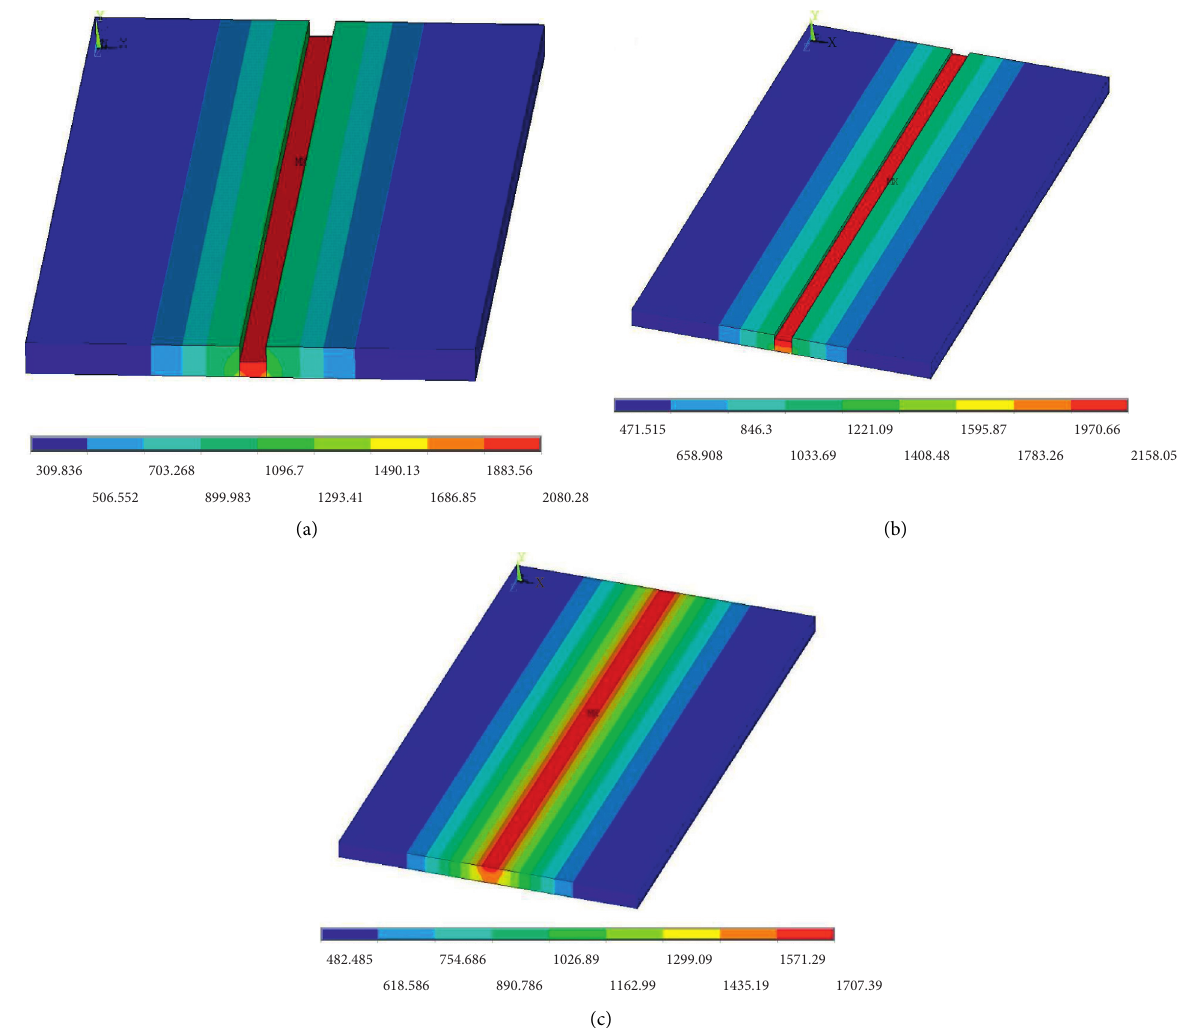
Figure 9: Distribution of temperatures in the weldment. (a) Weld pass-1. (b) Weld pass-2. (c) Weld pass-3.